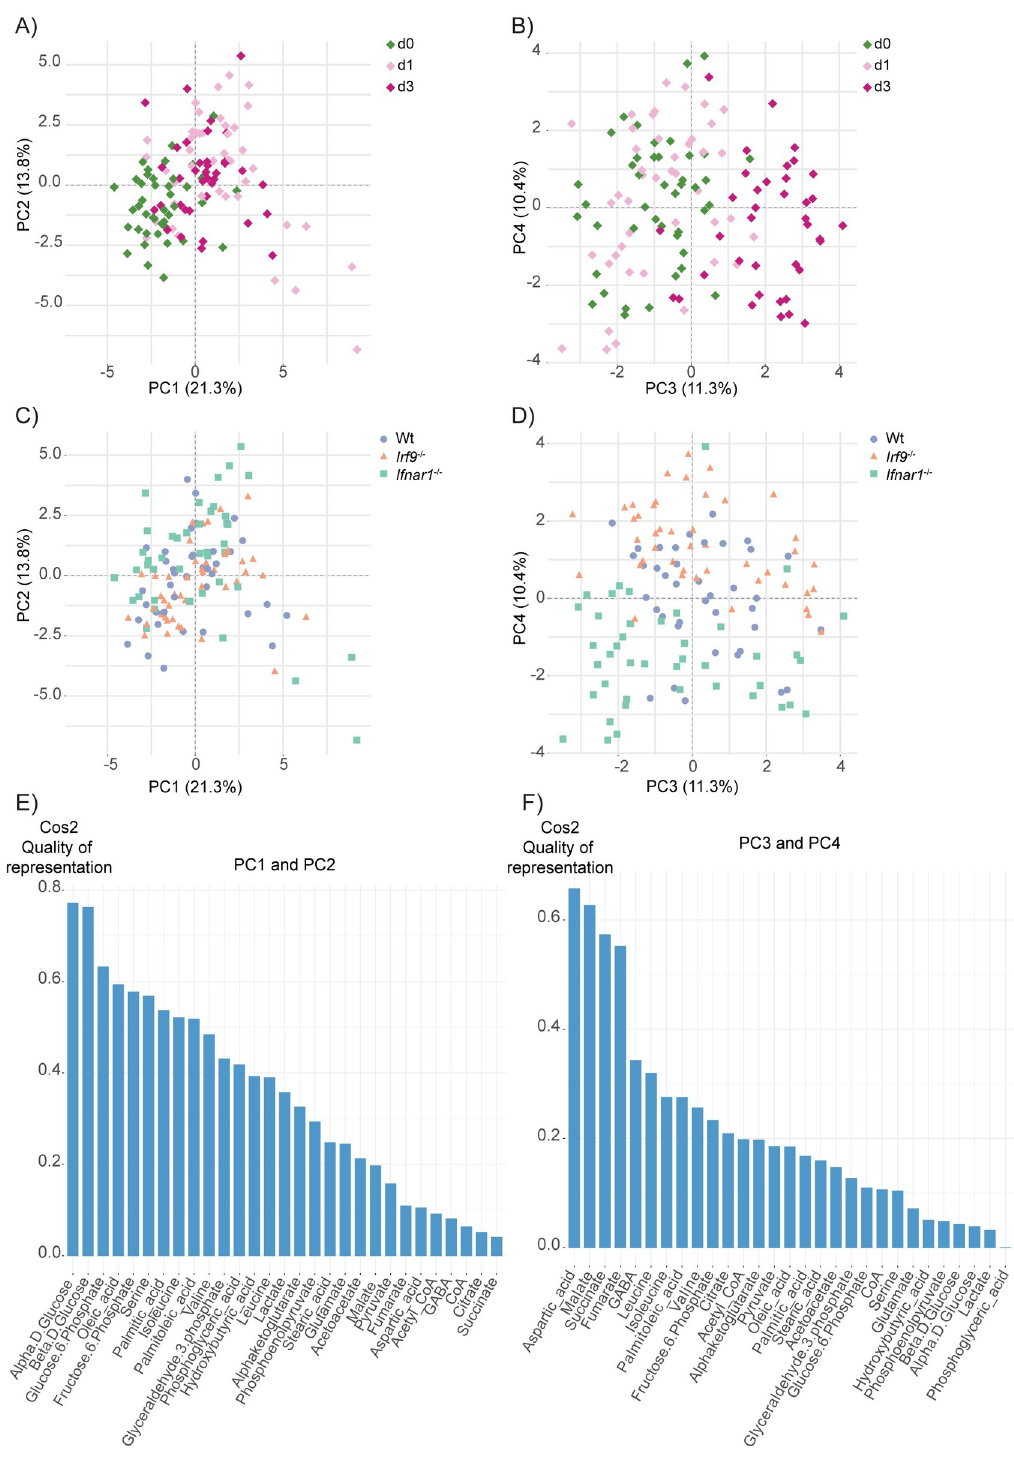
Fig 4. L . monocytogenes infection and IFN-I signaling induce metabolic changes in the liver. PCA plots of metabolites quantified by targeted LC-MS/MS from livers of (A-B) uninfected, one-day- or three-day-infected and (C-D) wt, Irf9 -/- and Ifnar1 -/- mice. Percentage of total variance is indicated in the axis label. Bar graphs showing contribution of each metabolite to clustering in (E) PC1 versus PC2 and (F) PC3 versus PC4. The values are corrected for liver weight, genotype, sex of the mouse and time point effects. ANCOVA test was performed. Contrib.: contribution, PC: Principal component.